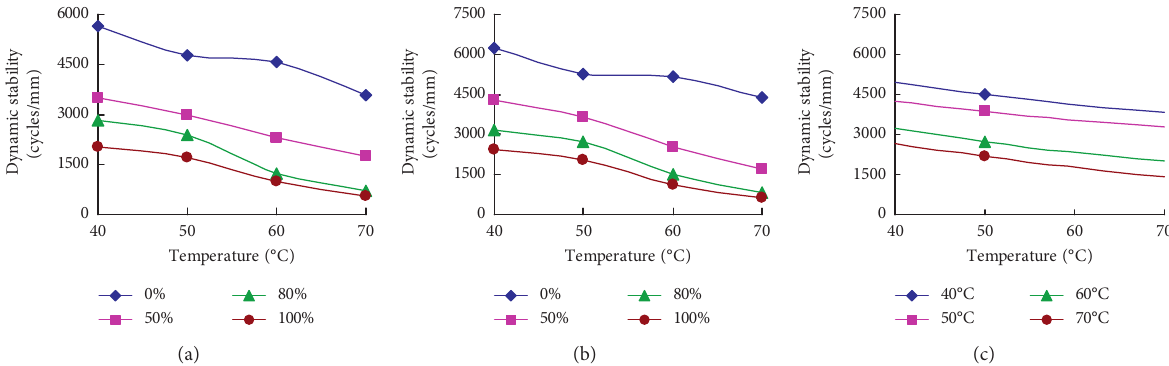
Figure 4: Relationship between dynamic stability and temperature at different saturated water ratios. (a) 1% content. (b) 2% content. (c) 3%